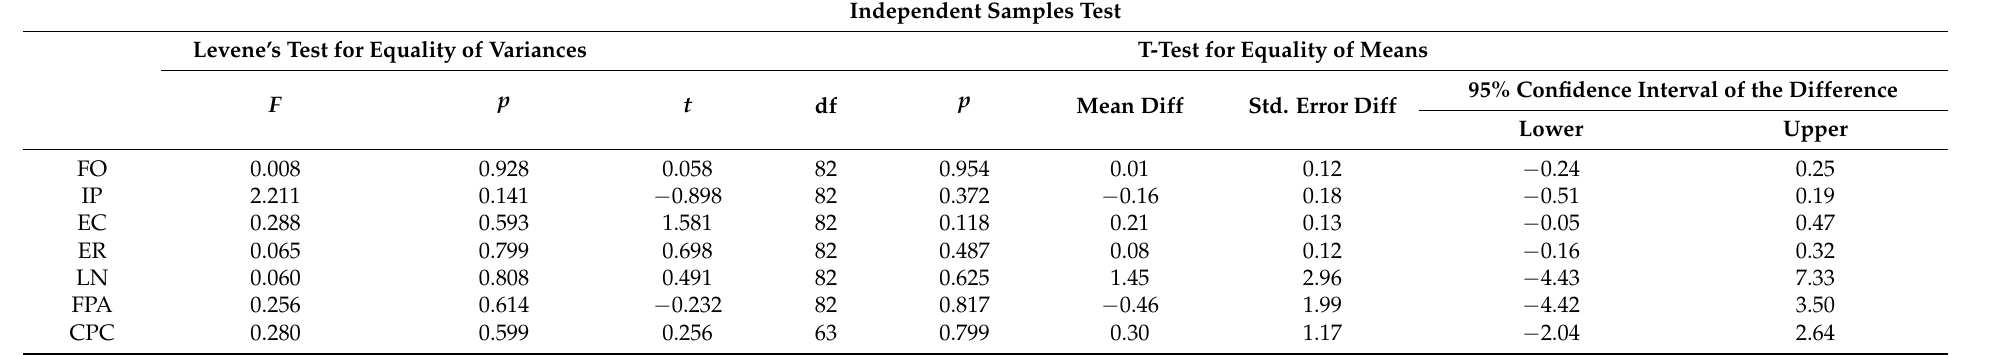
Table 4. Summary of Gender